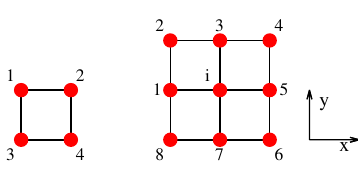
Figure 1. The unit cell ( left ) and the supercell ( right ) of a square lattice.